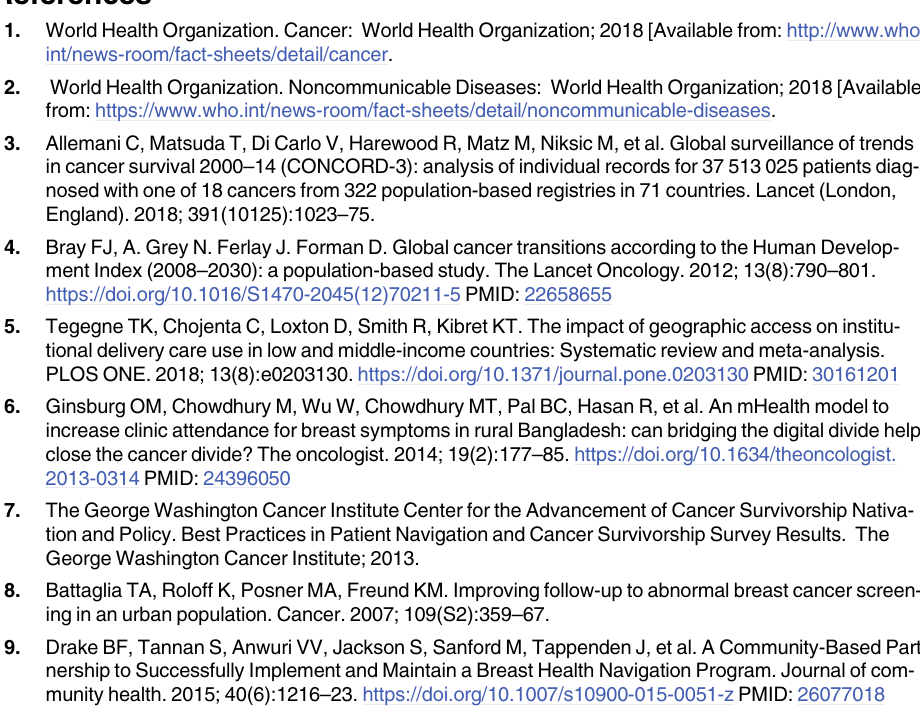
S1 Table. Systematic review search strategy. Search terms used to identify